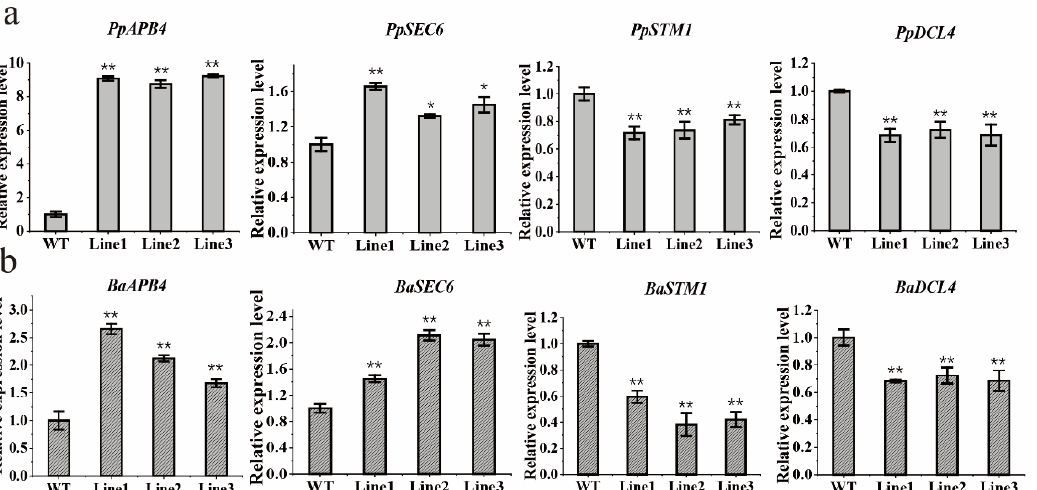
Figure 7. Relative expression levels of the growth- or development-related genes of BaZFP1 in mosses. ( a ) BaZFP1 -overexpressing P. patens ; ( b ) BaZFP1 -overexpressing B. argenteum . WT, wild type. L1–L3 are independent transgenic lines. The data are the means ± standard deviations. Asterisks indicate significant differences between WT and transgenic lines (* p < 0.05; ** p < 0.01).